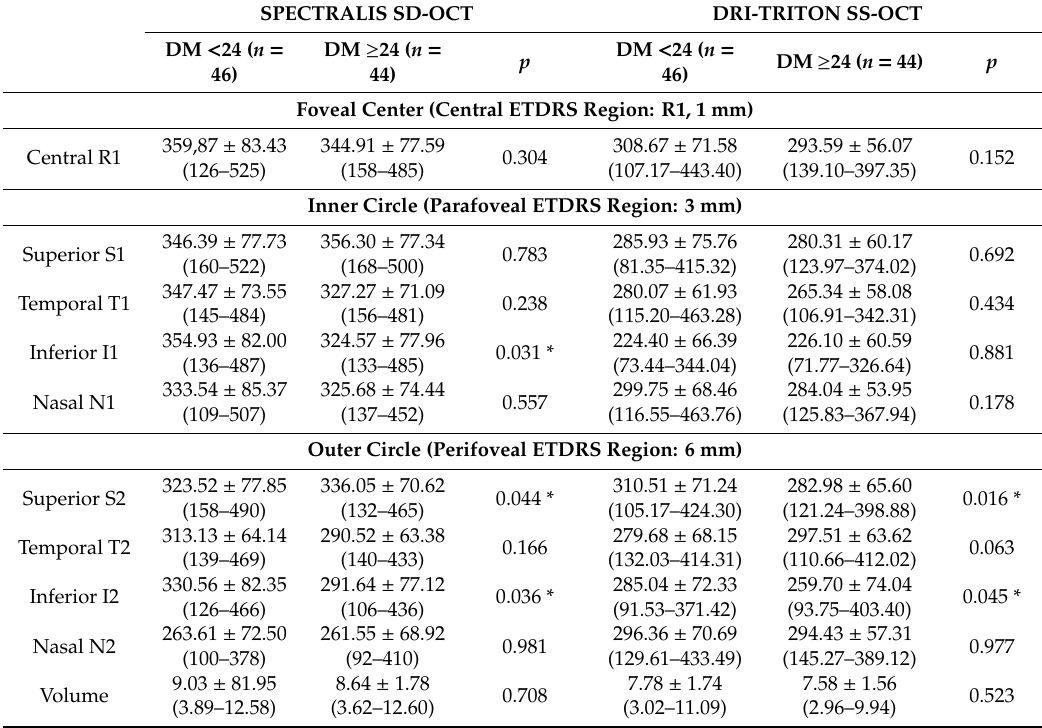
Table 4. Choroidal thicknesses by ETDRS quadrants in µ m (from the BM to the choroid-scleral limit) assessed with Spectralis spectral domain optical coherence tomography (SD-OCT) and the deep range imaging (DRI)-Triton swept source optical coherence tomography (SS-OCT) in the type 1 diabetes Mellitus (DM1) group subdivided into two groups: less than 24 years and over or equal to 24 years of evolution of DM1. Values are presented as the mean ± standard deviation and range (minimum–maximum). Significant di ff erences were considered as p < 0.05, calculated by Kolmogorov–Smirnov test for two independent nonparametric samples, are shown with *. The volume is represented in mm 3